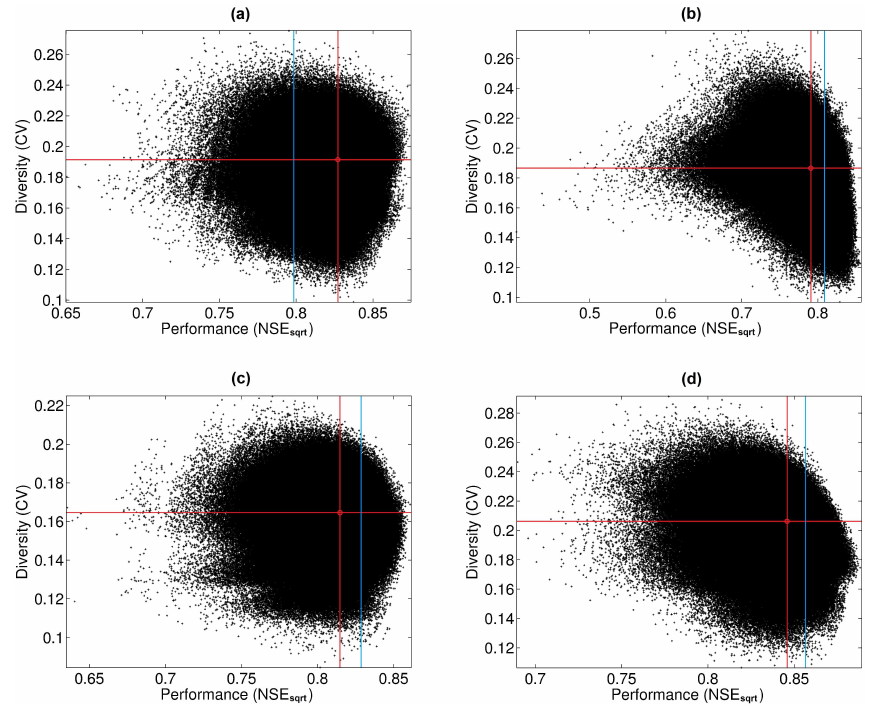
Fig. 12. Validation performance (NSE sqrt ) and diversity (CV) for all model combinations (2 20 points) and Differential Split Sample Tests for the Schlehdorf catchment (SLD): (a) calibration on DW years (dry/warm) and validation on HC years (humid/cold); (b) calibration on HC years (humid/cold) and validation on DW years (dry/warm); (c) calibration on DC years (dry/cold) and validation on HW years (humid/warm); (d) calibration on HW years (humid/warm) and validation on DC years (dry/cold). Red lines and circle illustrate performance and diversity of the twenty-member ensembles and blue lines, of the best individual model for each test.